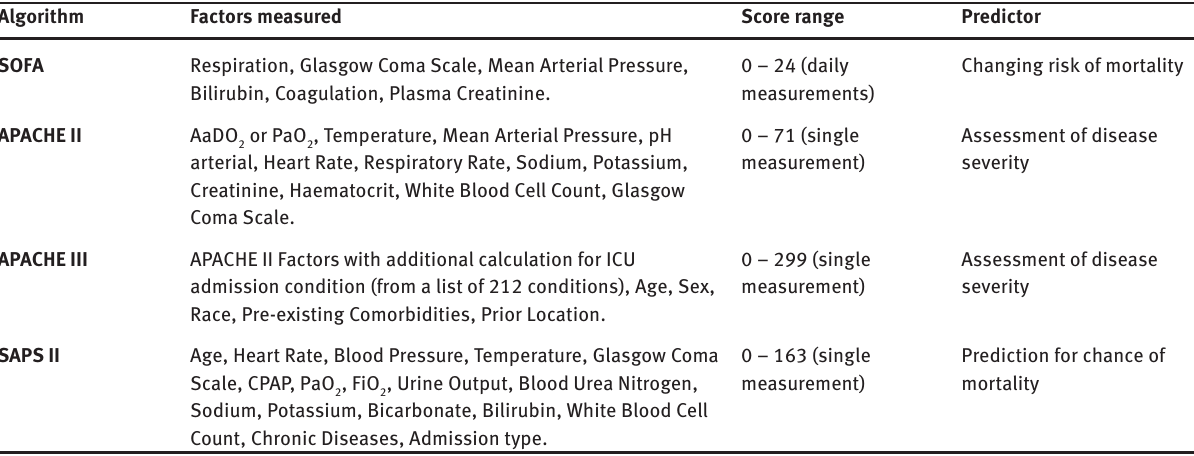
Table 1 : SOFA, APACHE II and III, and SAPS II assessment characteristics and score ranges.